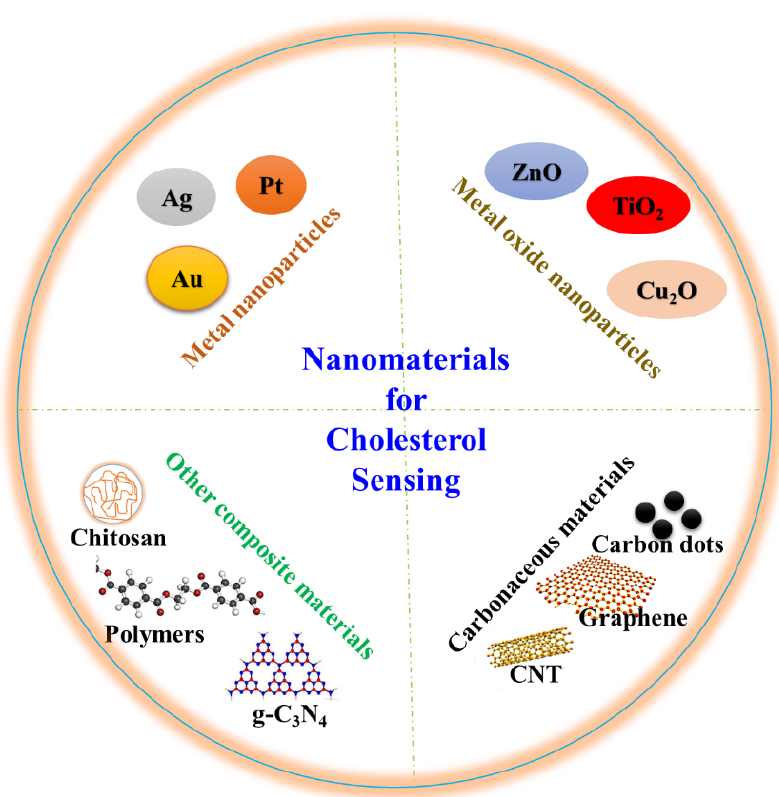
Figure 2. Nanomaterials for cholesterol sensing application.